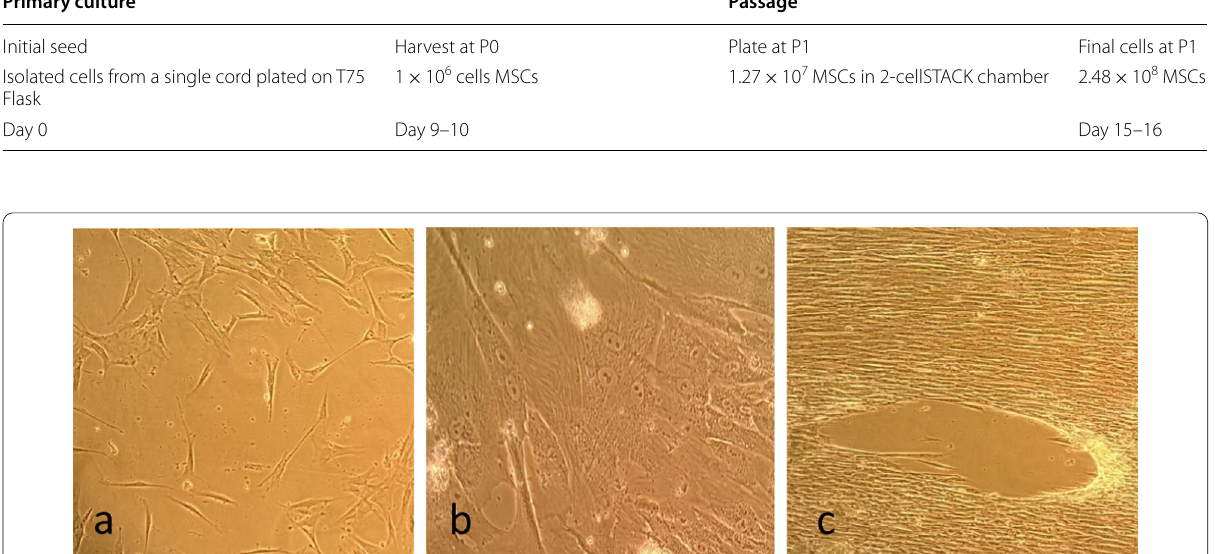
Table 1 UCMSCs has grown in culture media with Hyclone’s FBS Primary culture